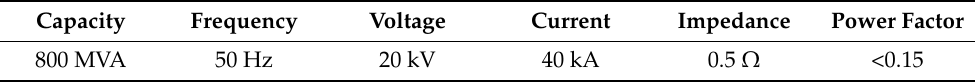
Table 6. Parameters of the power supply.